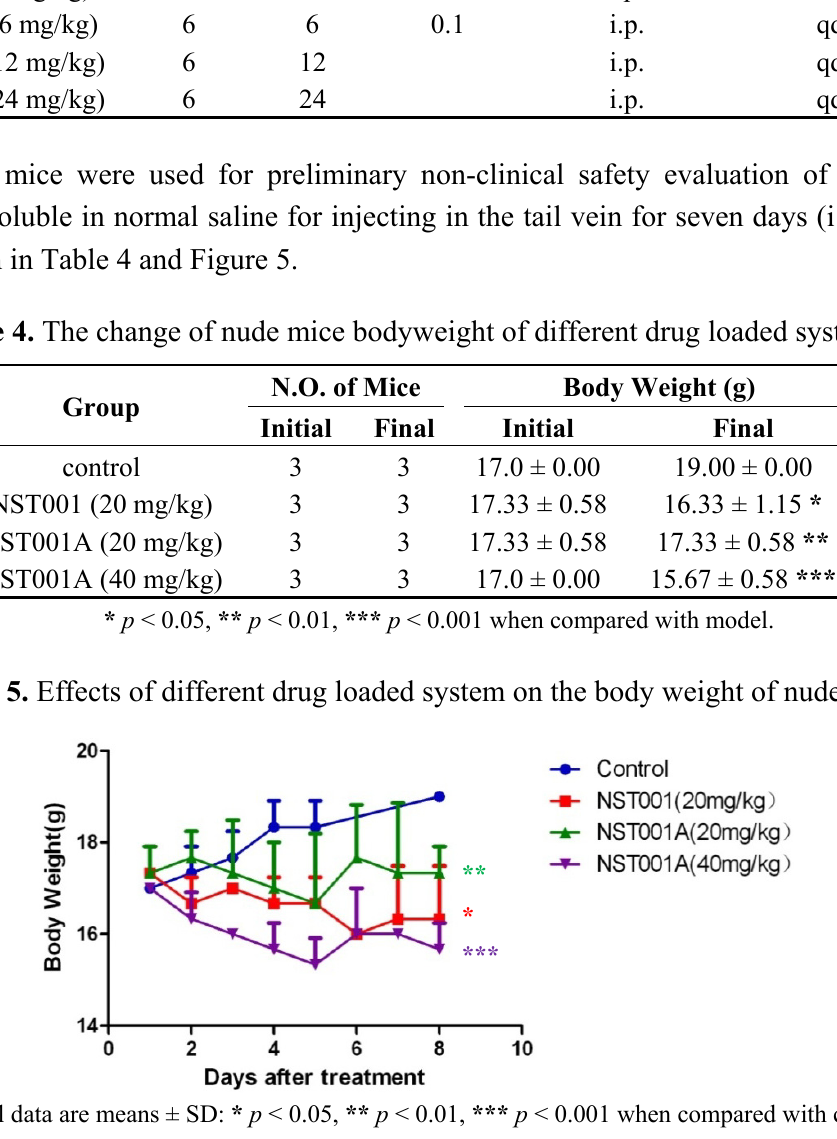
All data are means ± SD: * p < 0.05, ** p < 0.01, *** p < 0.001 when compared with